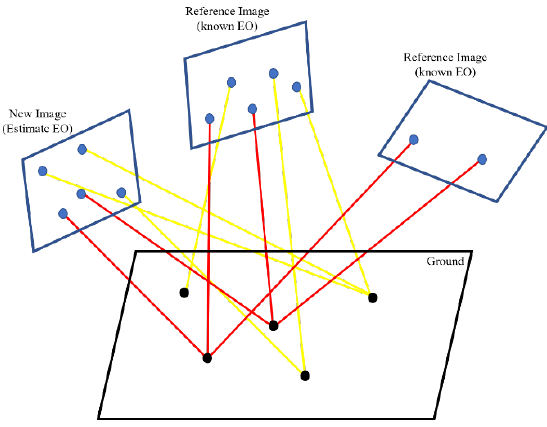
Figure 2. Concept of Estimating the EO of a new image